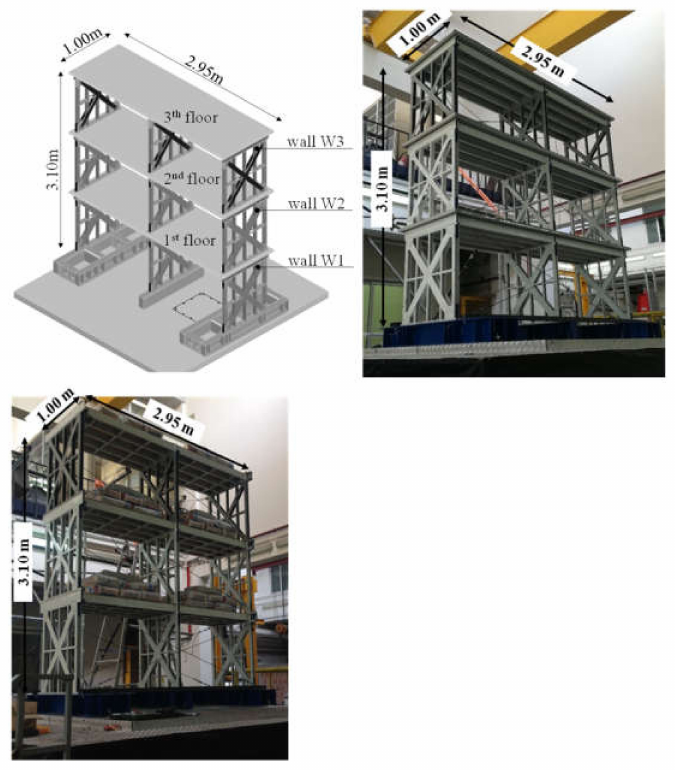
Figure 1. Reduced scale tested mock-ups